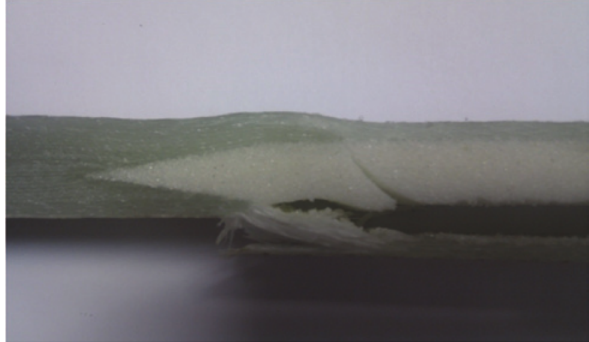
Figure 13 Crack in the foam and in compression skin and gap in the foam.